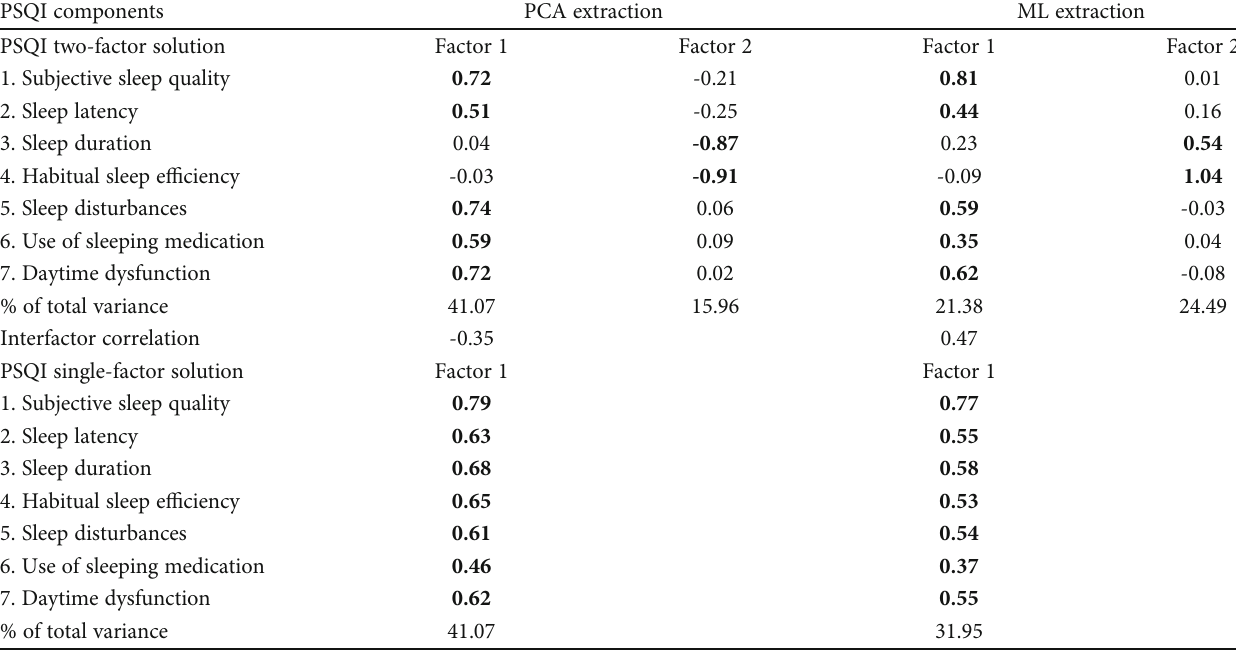
Table 2: Factor pattern matrix for the PSQI two-factor solution and factor matrix for the PSQI single-factor solution, comparing two extraction methods.